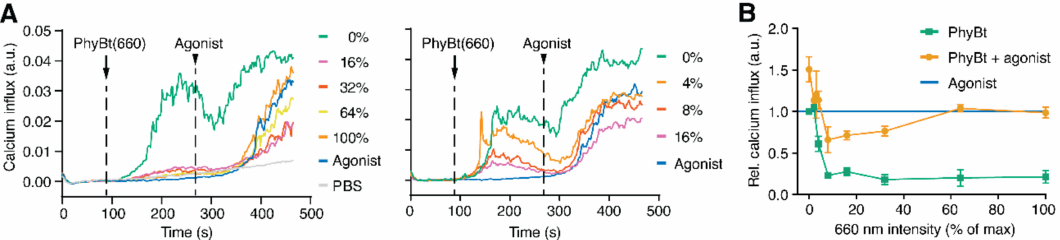
Figure 3. Cross-modulation of agonist stimulation using optogenetically controlled ligand-binding times. ( A ) JK82 cells were first treated with 63 nM PhyBt(660) (arrow) under different 660 nm light intensities as depicted and then in addition with 50 ng/mL of the agonist anti-V β 8 (arrowhead) while measuring calcium influx using flow cytometry. Additionally, cells were treated with PBS only (arrow and arrowhead) or first with PBS (arrow) and then with the agonist at the arrowhead time point. One representative experiment of n = 13 is shown. ( B ) The relative calcium influx was quantified from experiments as in ( A ) for the PhyBt(660) treatment alone (green rectangles) or combined with the agonist (orange dots) from 13 different experiments as described in the methods. The blue horizontal line indicates stimulation by the agonist